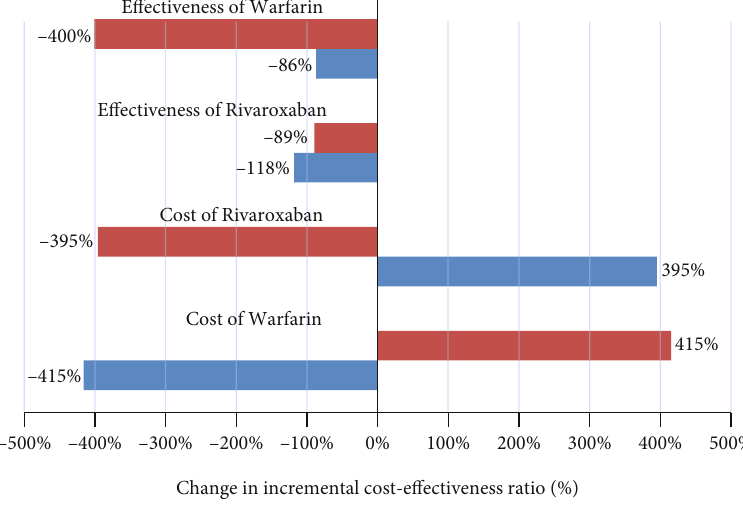
Figure 2: Tornado diagram of cost-e ff ectiveness to prevent of ischemic stroke for patients with AF under treatment with rivaroxaban and